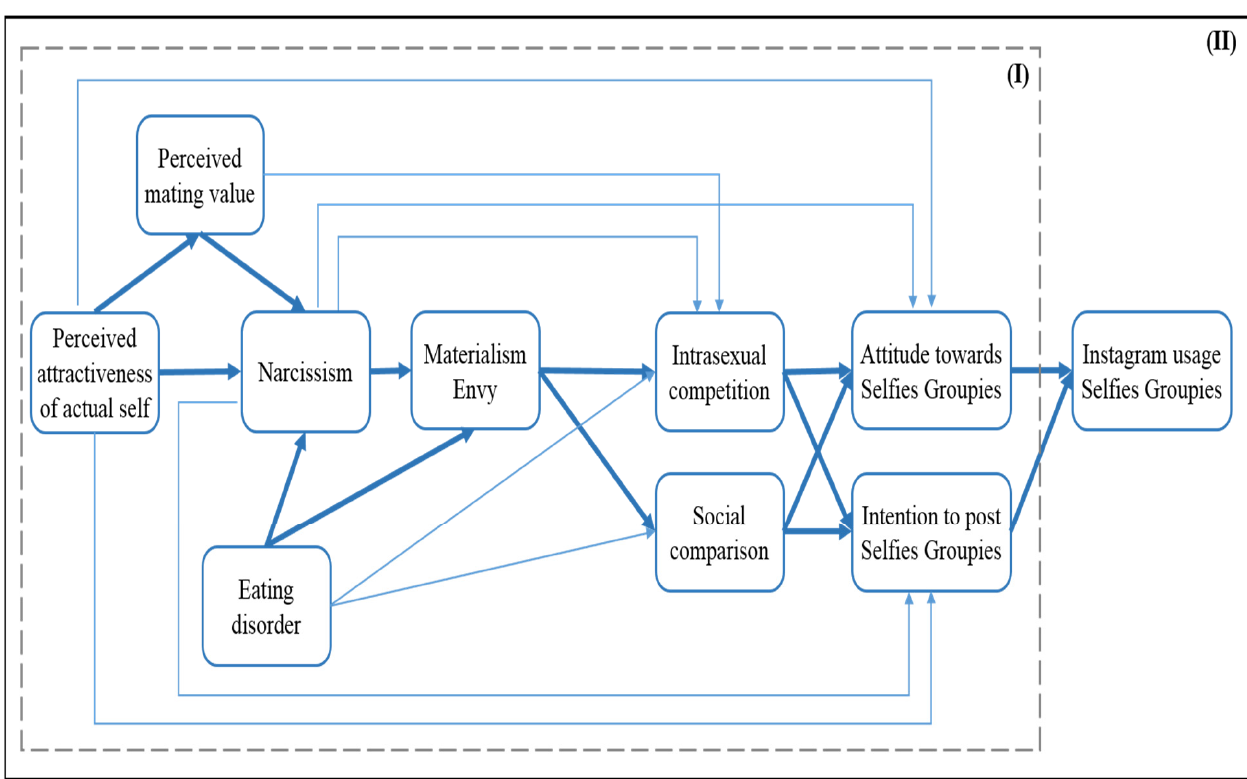
Figure 3. Study 3: Conceptual model ( a ) and modified model ( b ).